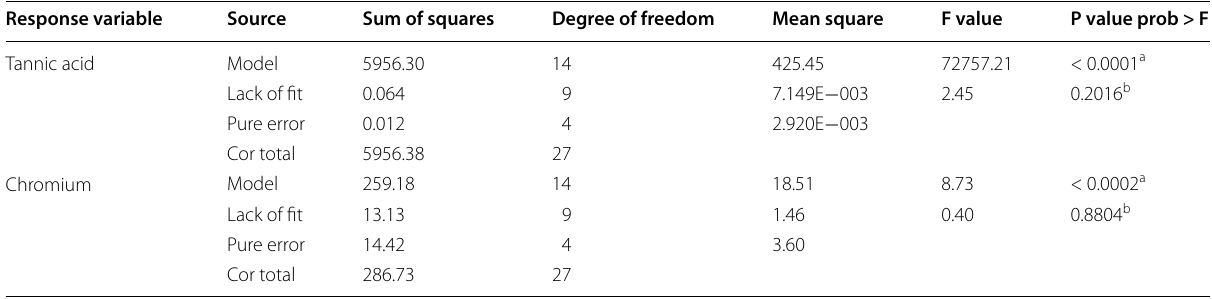
Table 4 Analysis of variance (ANOVA) of A. niveus for the fitted quadratic polynomial model for residual tannic acid and